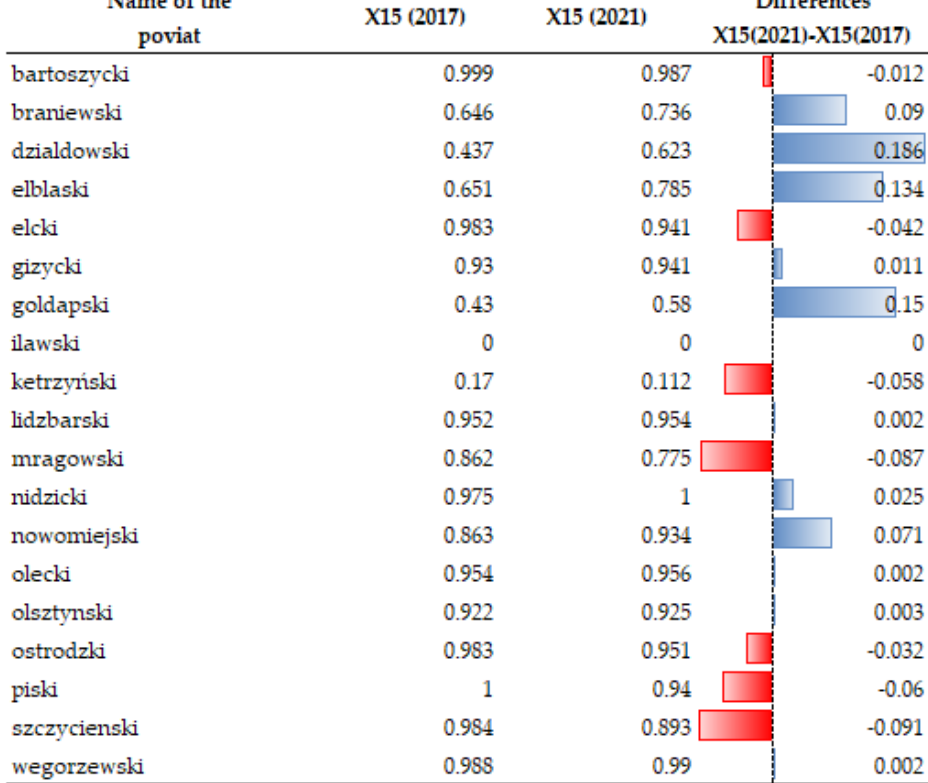
y = 0.0075x + 0.2912 y = 0.0058x + 0.3193